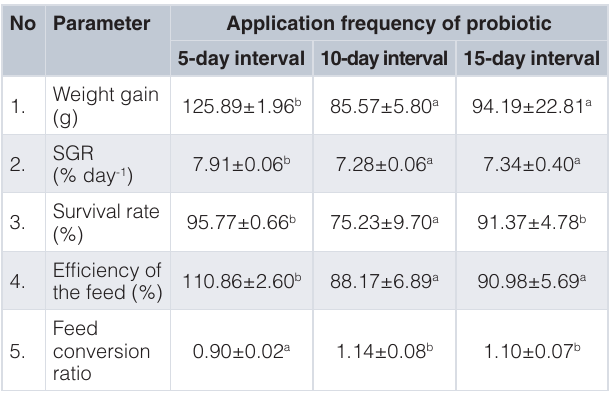
Table 1. The growth performance, survival rate, and feed utilization of African catfish, Clarias gariepinus. Mean of values in the same row followed by a different superscript that are significantly different (p< 0.05).